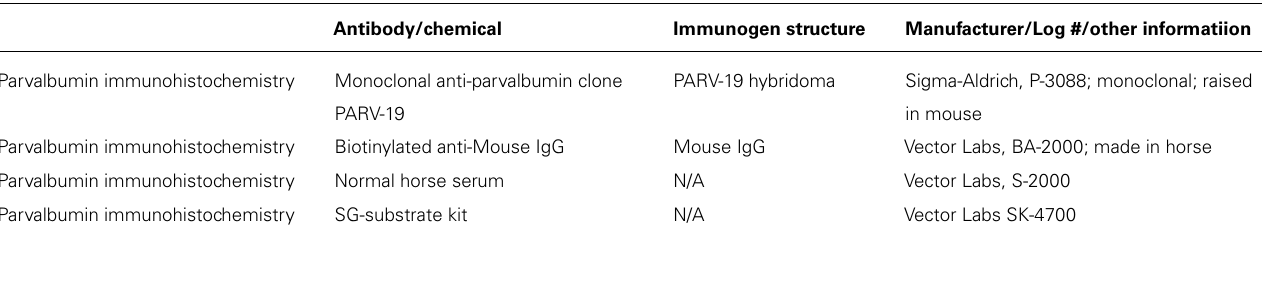
The density of the sample was calculated by dividing the estimated cell count by the estimated volume ( E n / V ref ).